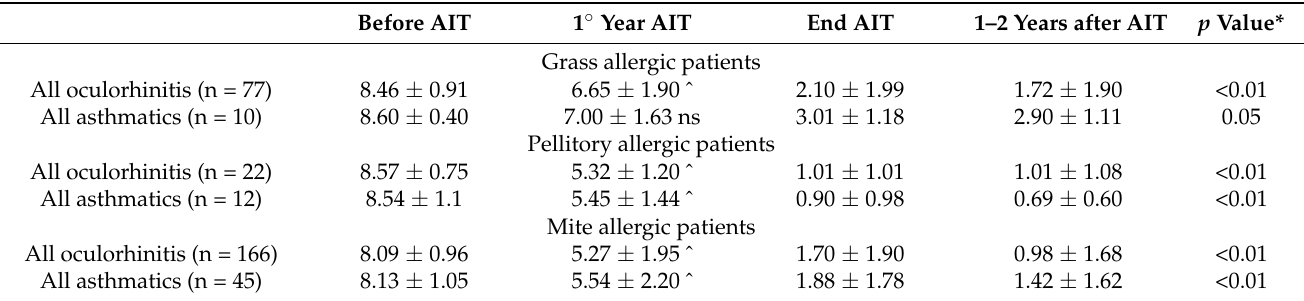
Table 2. VAS changes in AIT-treated patients divided by allergic sensitization.